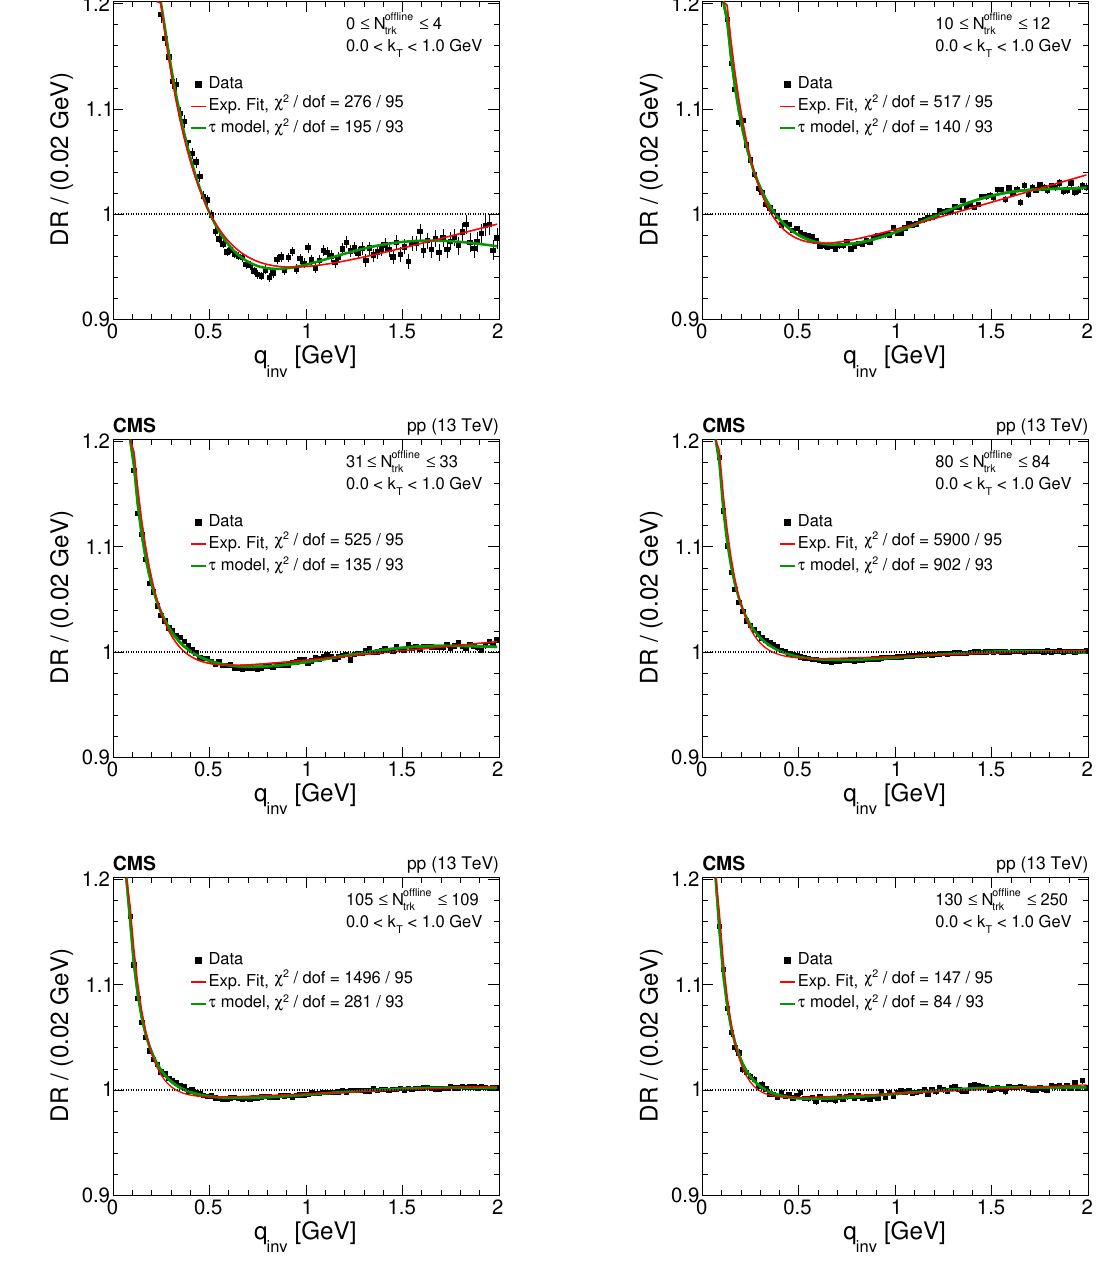
Figure 10 . Correlation functions from the double ratio technique, integrated in the range 0 < k < 1 GeV, in six multiplicity bins. The results are zoomed along the vertical axis. The error bars T represent statistical uncertainties and in most cases are smaller than the marker size.